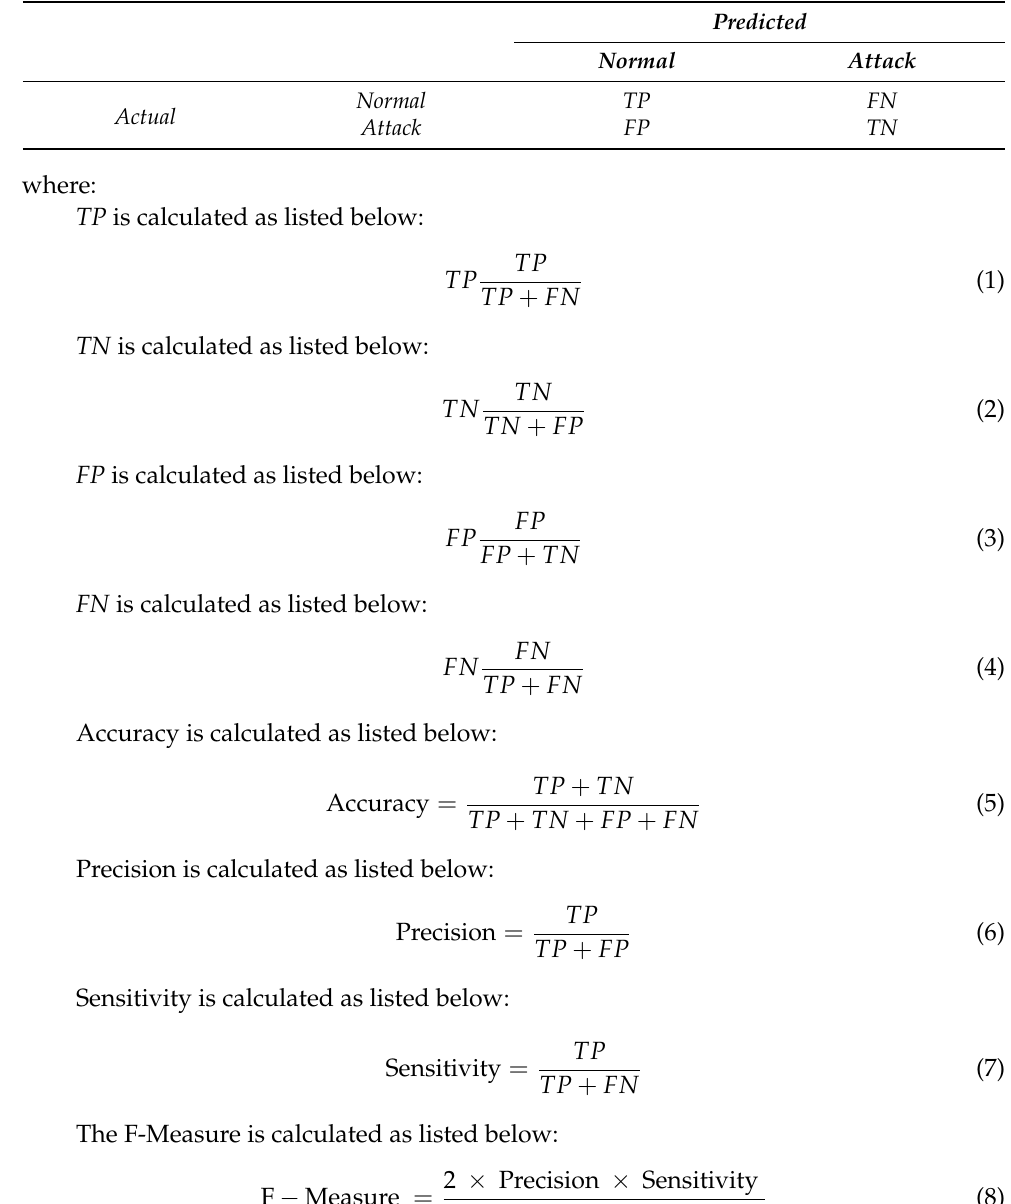
Table 5. Matrix of